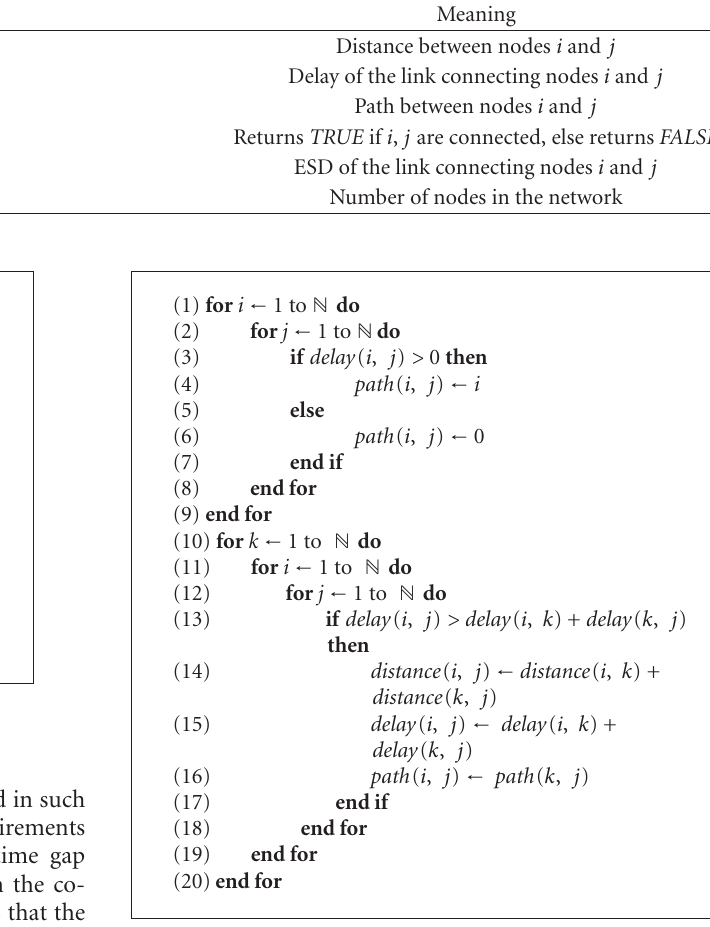
Algorithm 2: Computation of routing